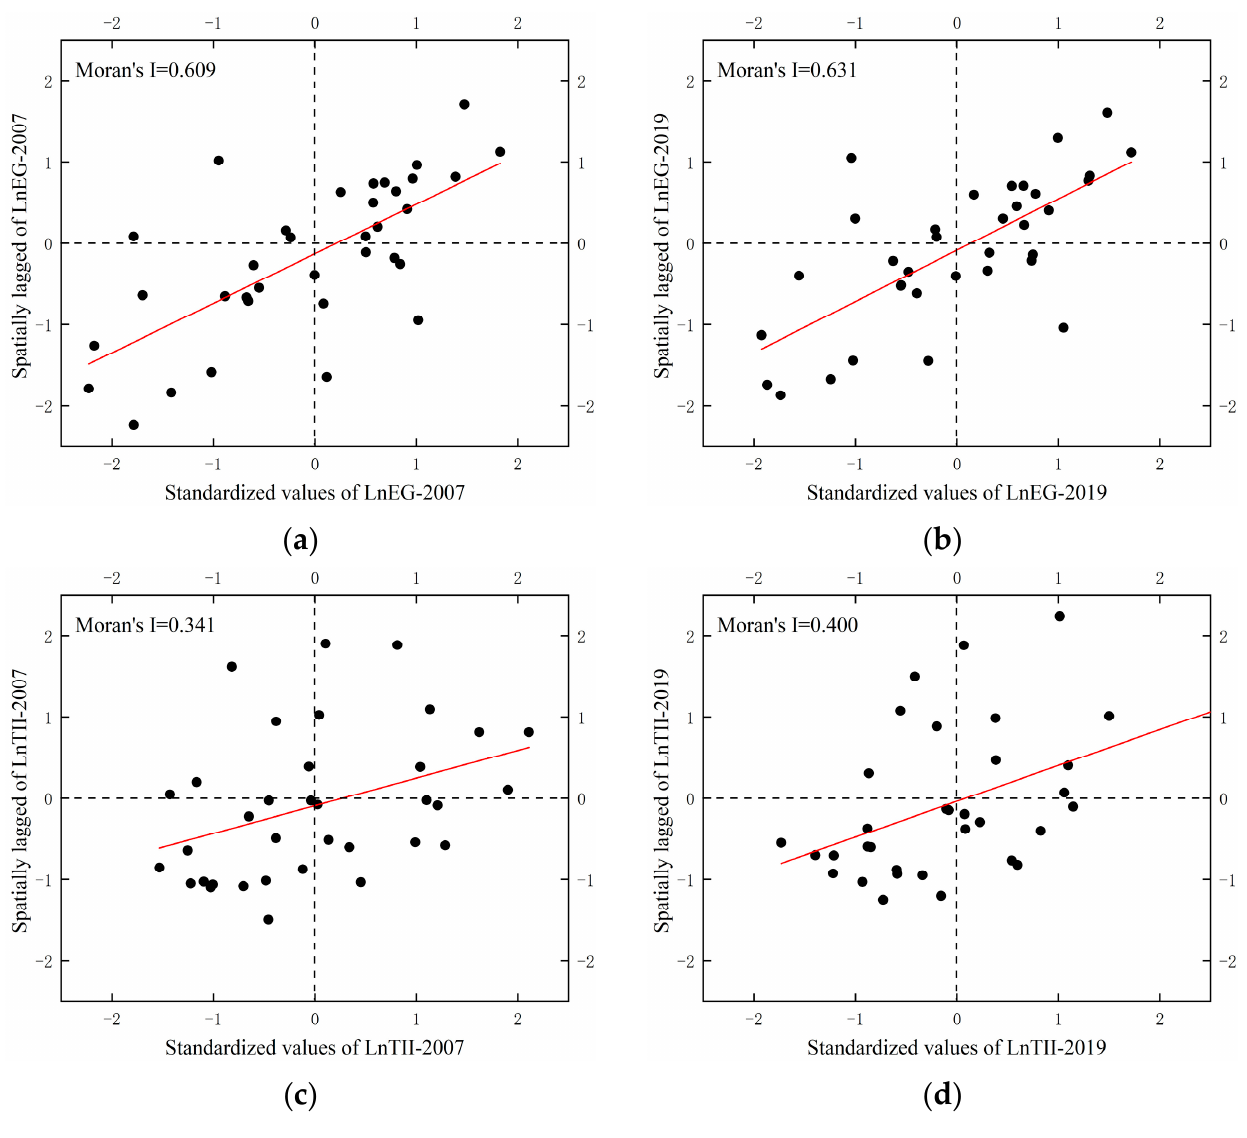
Figure 6. Local Moran’s I scatter plot of EG and TII in 2007 and 2019. ( a ) Local Moran’s I of ln EG in 2007. ( b ) Local Moran’s I of ln EG in 2019. ( c ) Local Moran’s I of ln TII in 2007. ( d ) Local Moran’s I of ln TII in 2019.